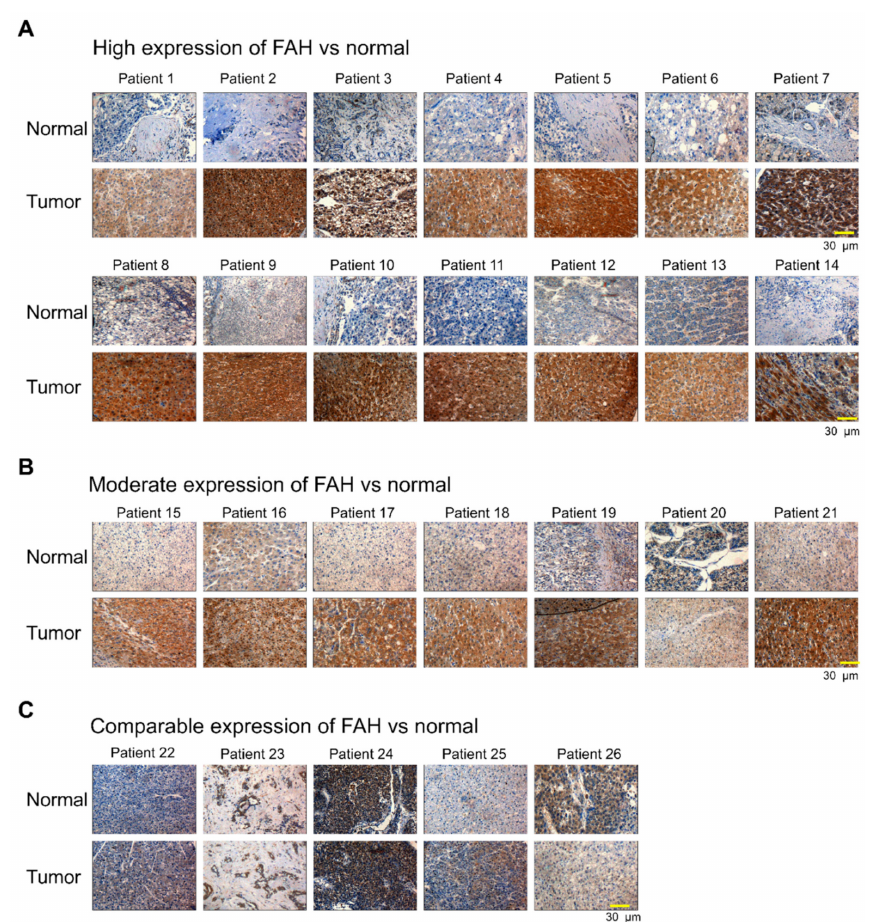
Figure 1. Fumarylacetoacetate hydrolase (FAH) protein expression in human hepatocellular carcinoma (HCC) tumor tissues. ( A ) Representative immunohistochemical staining of endogenous FAH in 14 patient-derived normal and tumor tissues showing high expression of FAH in tumor samples. ( B ) Representative immunohistochemical staining of endogenous FAH in 7 patient-derived normal and tumor tissues showing moderate expression of FAH in tumor samples. ( C ) Representative immunohistochemical staining of endogenous FAH in 5 patient-derived normal and tumor tissues showing comparable expression of FAH in tumor samples (scale bar = 30 µ